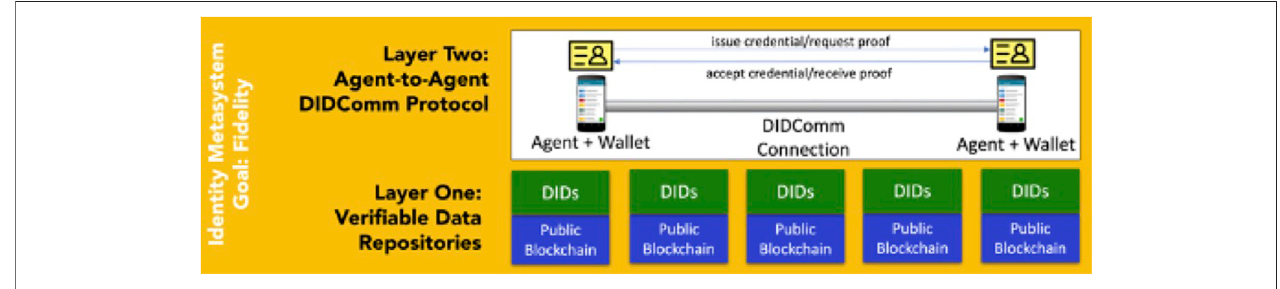
FIGURE 6 | The identity